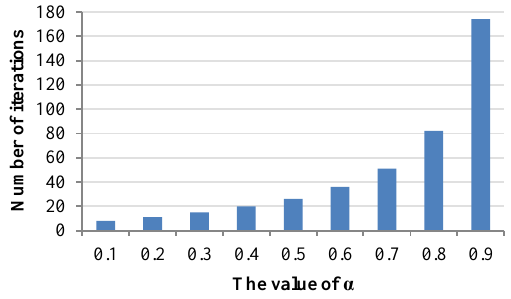
Figure 3. Effect of α on the number of iterations of the algorithm.